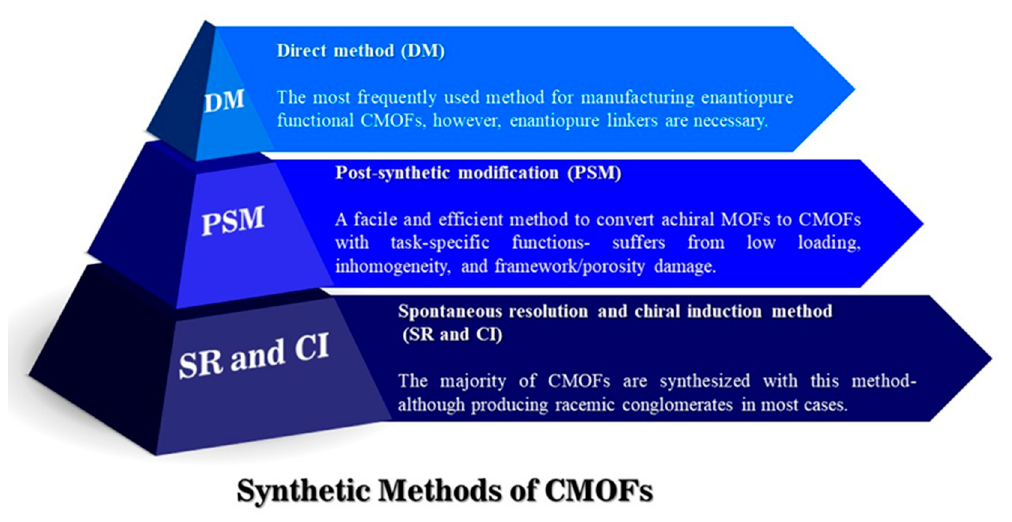
Figure 2. Three synthetic methods of chiral MOFs with a summary of their merits and drawbacks.